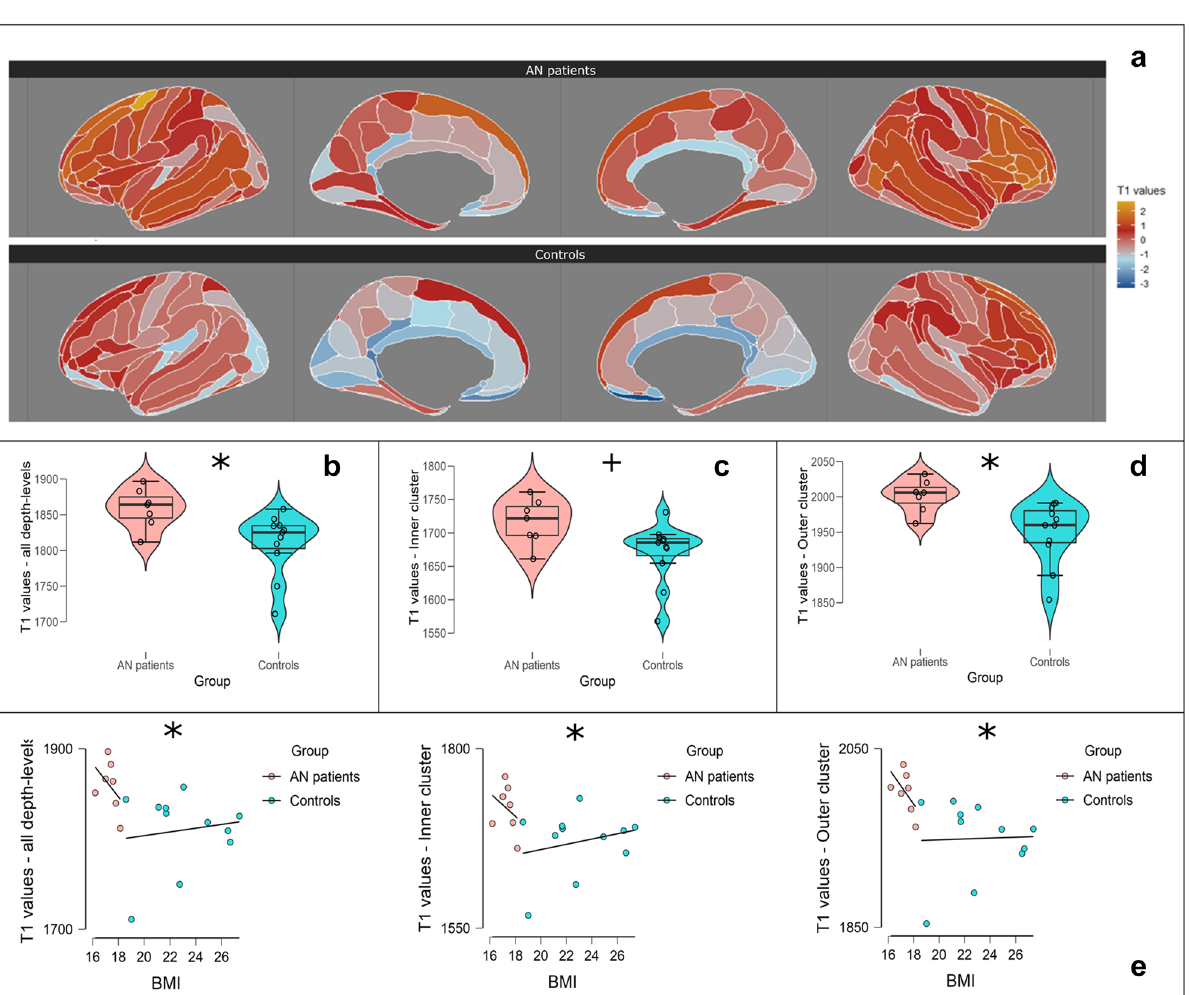
Figure 1. (a) Standardized total T 1 values map for AN patients (top) and controls (bottom). Maps are based on the Destrieux’s Atlas and show T 1 values’ average across 10 depth-levels per each Region-of-Interest (ROI) in AN patients and healthy controls. For illustrative purposes, the distribution of T1 values was rescaled to a distribution with mean = 0. ( b) Boxplot with violin and jitter elements displaying distribution of T 1 values (in ms) as intracortical myelin concentration index averaged across all 10 cortical depth-levels for AN patients and controls; ( c) boxplot with violin and jitter elements displaying distribution of inner cluster’s T 1 values (in ms) for AN patients and controls; ( d) boxplot with violin and jitter elements displaying distribution of outer cluster’s T 1 values (in ms) for AN patients and controls; ( e) scatterplots between BMI and T 1 values (in ms) in all depth-levels, inner and outer clusters in AN patients and controls. For illustrative purposes groups are shown separately, although the statistical significance symbol refers to the analysis on overall population. T 1 values distributions between AN patients and controls and relationship between T1 values and BMI. *p < 0.05; + p =